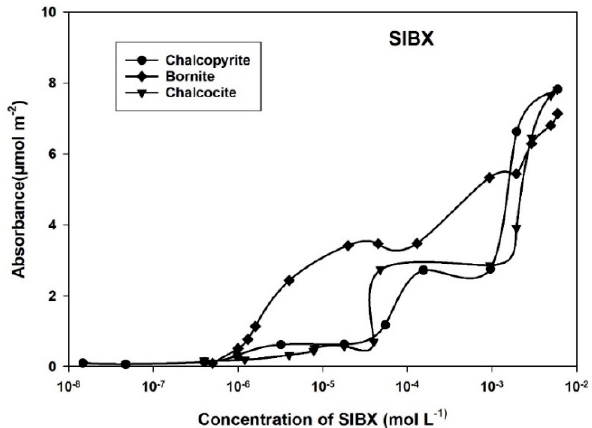
Figure 12. The adsorption of xanthate from a mixture of xanthate and dithiophosphate on the copper sulphide surface at pH 8.